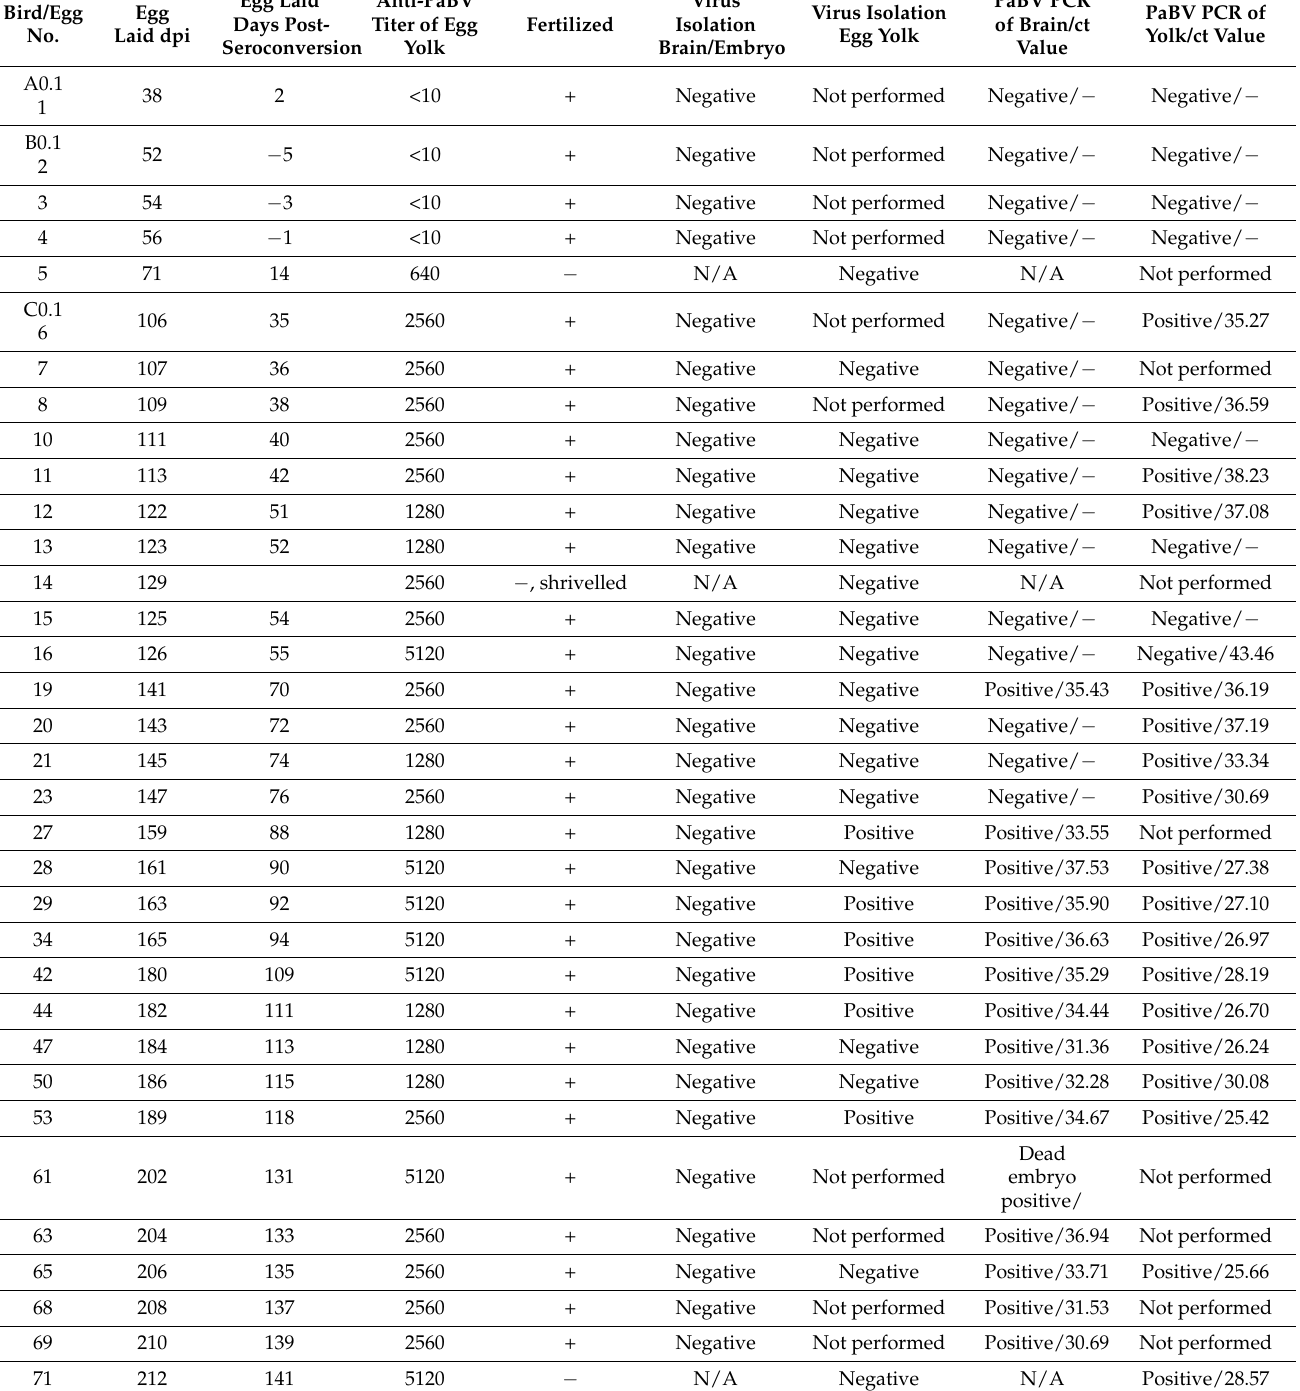
Table A1. Results of PaBV-specific PCR in embryo brains and egg yolk and results of virus isolation from embryo and egg yolk in the adult infected group sorted by egg number; “+” means the egg was fertilized, “ − “ means the egg was unfertilized. A0.1 seroconverted at 36 dpi with a titer of 1:640, B0.1 seroconverted at 57 dpi with 1:320, C0.1 seroconverted at dpi 71 with 1:320, E0.1 seroconverted at 36 dpi with 1:160, F0.1 seroconverted at day 57 with